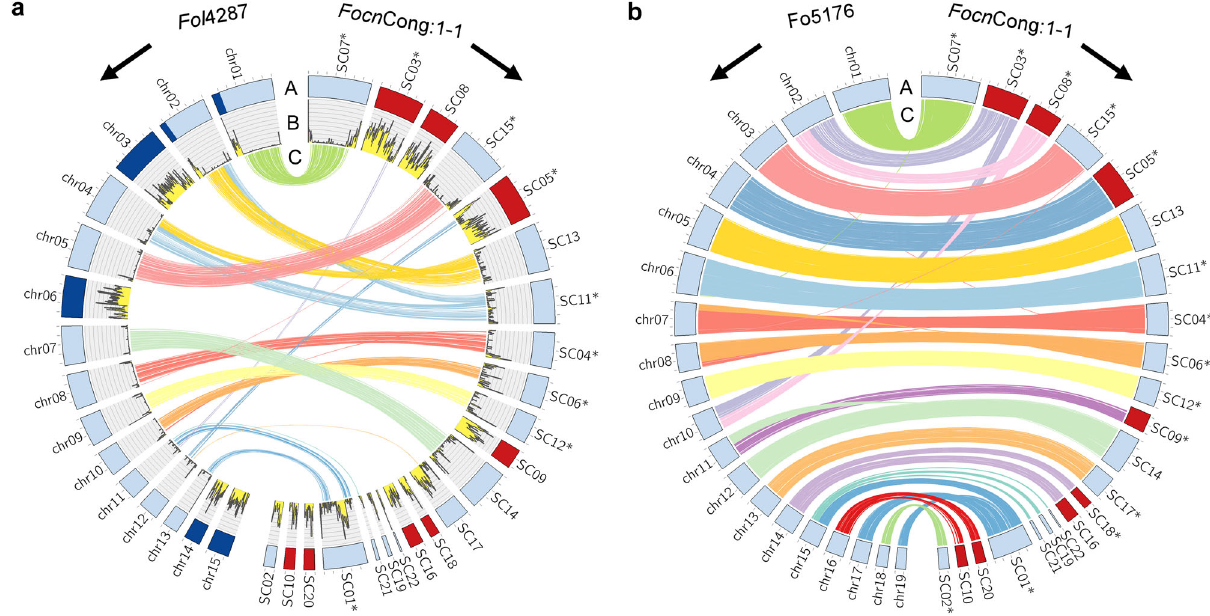
Fig. 1 Comparison of whole genome assemblies among Focn Cong:1-1, Fol 4287, and Fo5176. Whole genome assemblies were compared between Fol 4287 and Focn Cong:1-1 ( a ) and between Fo5176 and Focn Cong:1-1 ( b ). Ring A: Circular representation of the pseudomolecules. Red and dark blue indicate dispensable genomic regions in Focn Cong:1-1 and known accessory regions in Fol 4287 (chr1B; chr2B; chr3; chr6; chr14; chr15) 6 , respectively. Light blue indicates the remaining regions. Ring B: Distribution of transposable elements (TEs) in 50 kb windows. Proportions of sequences of respective Focn Cong:1-1 SCs associated with TEs are shown in Supplementary Fig. 1. Ring C: Syntenic regions (>95% identity, 30 kb) between Fol 4287 and Focn Cong:1-1 assemblies ( a ) and between Fo5176 and Focn Cong:1-1 assemblies ( b ). Asterisks indicate reverse-complemented scaffolds (SCs) for visual clarity. Ticks on bands represent 1